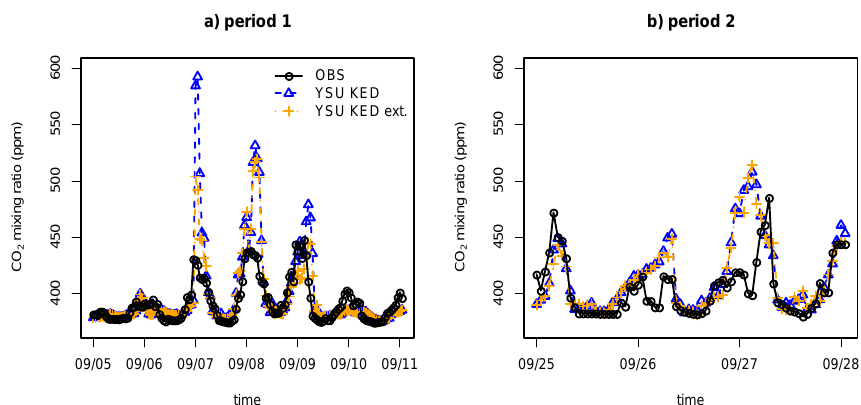
Figure 13. Observed and simulated CO 2 time series for period 1 (a) and 2 (b) of 2009 at Cabauw 20m (a.g.l.). Shown here is the STILT/YSU simulations for which deterioration in simulated CO 2 was most notable when using optimized MHs (blue triangles). Using additional night- time MHs observed at Cabauw to condition the KED optimization reduces the overcompensation in period 1 notably ( a , orange pluses). No such effect is observed in period 2 (b)